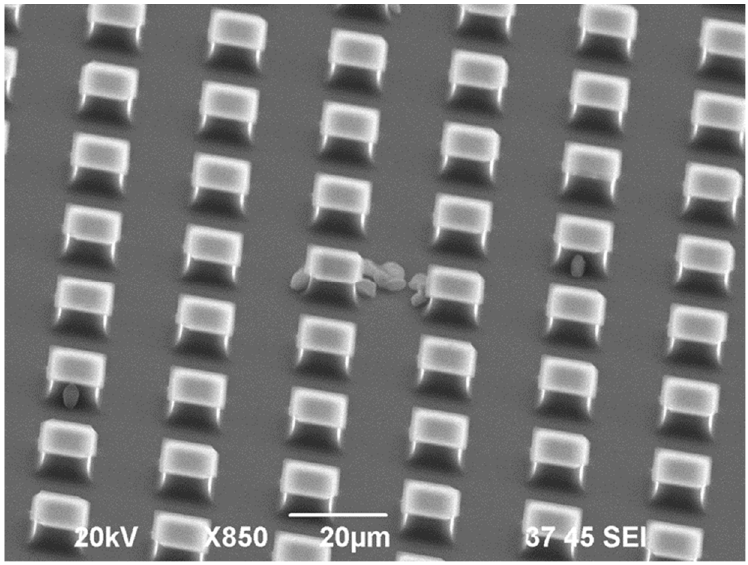
Figure 7. SEM image of the substrate with the immobilized cells.